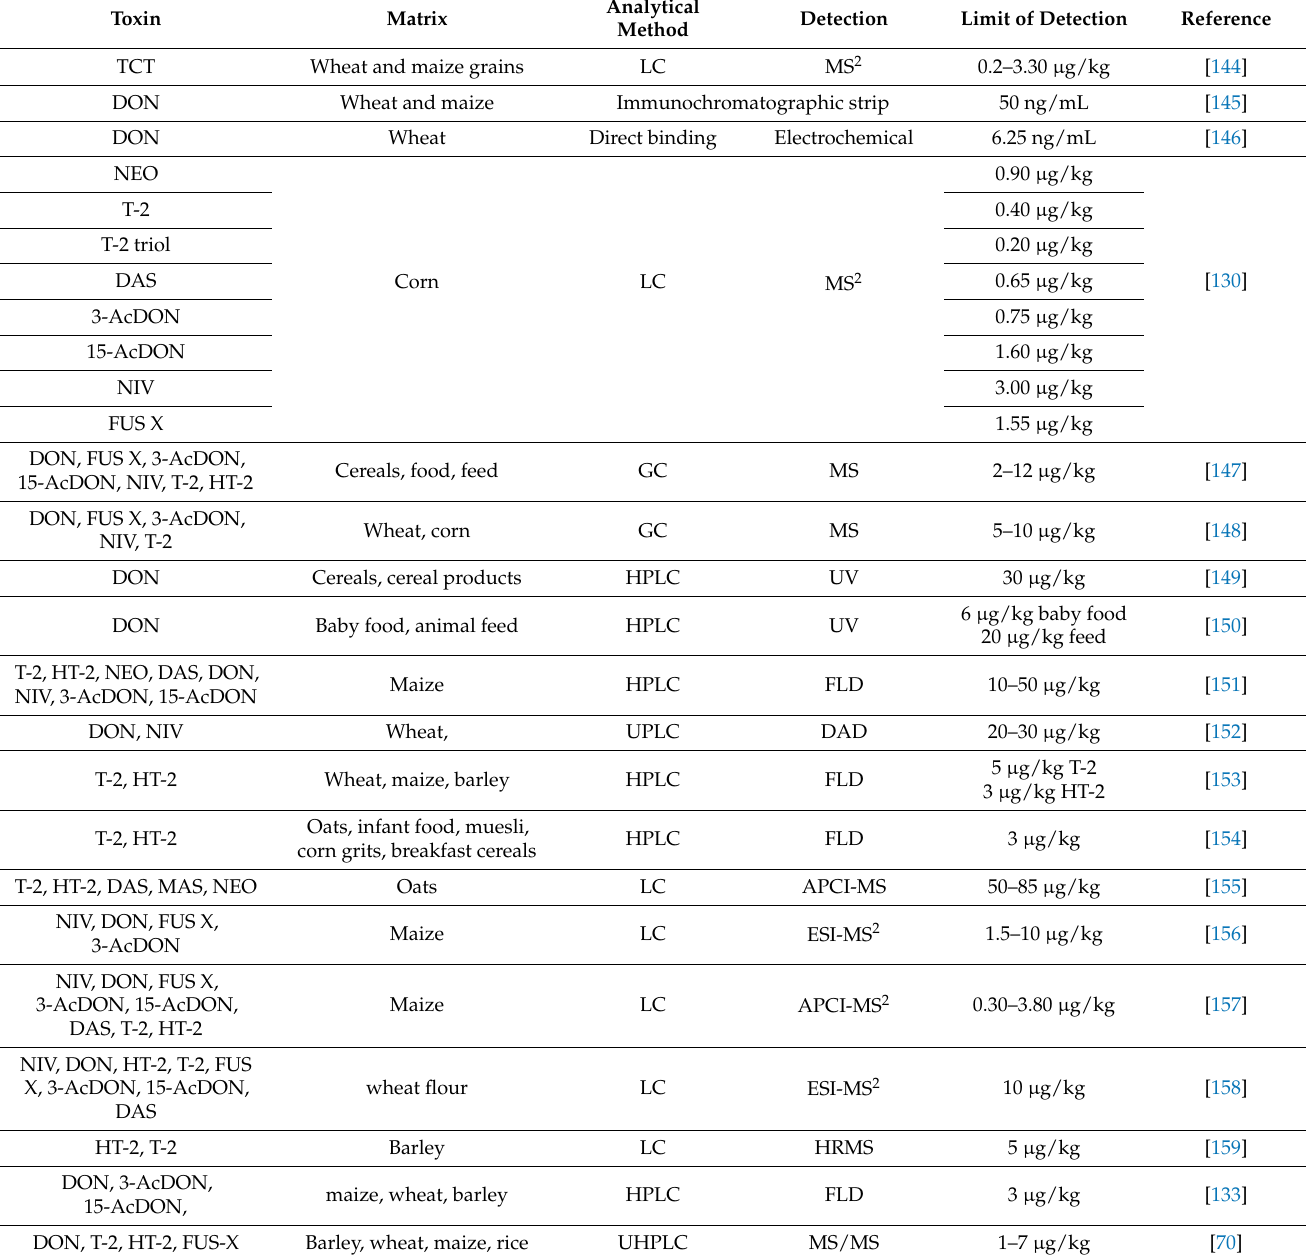
Table 3. Analytical methods for trichothecene determination in cereals and cereal-based